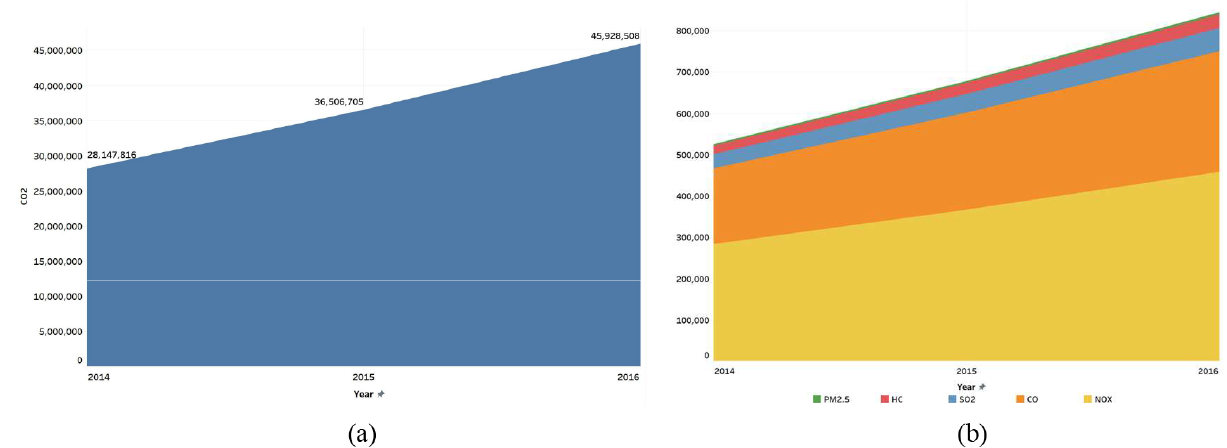
Figure 4. Annual overall emissions of six pollutants before the CNG2020 strategy was proposed (tonnes). (a) Annual overall emissions of CO 2 from 2014 to 2016. (b) Annual overall emissions of the other five pollutants from 2014 to 2016.